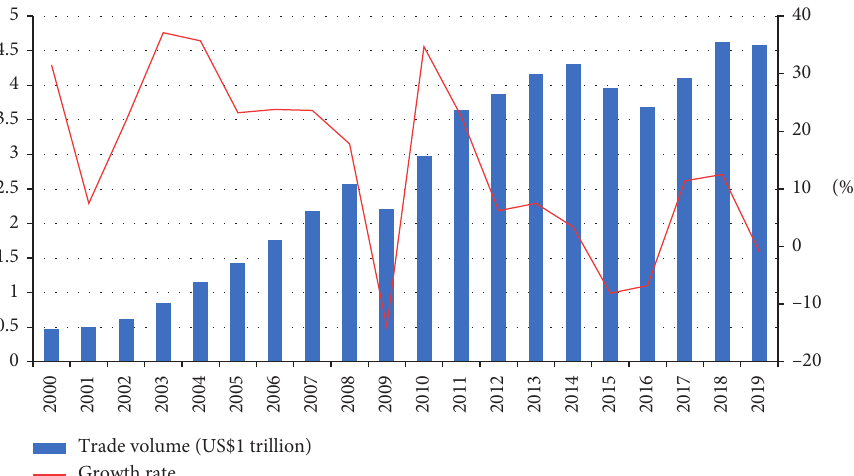
Figure 1: China’s total import and export and growth rate from 2000 to 2019. Source: Yearbook of Foreign Economic Statistics of China.